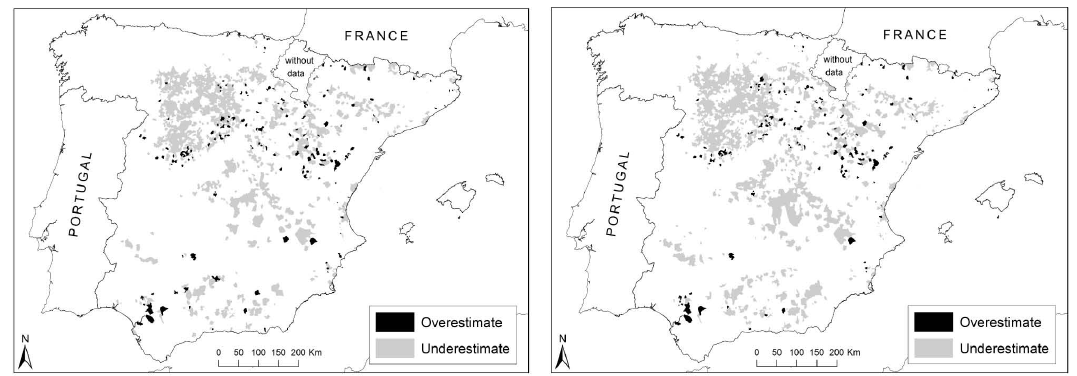
Fig. 2. Municipalities where prediction and observation data did not agree; either fire is predicted when it is not observed (overestimated) or fire is not predicted when it is observed (underestimated). Ordinary logistic regression on the right and GW logistic regression on the left. Table 2. Residual spatial performance of logistic models using the Average Nearest Neighbour Distance Analysis. Ordinary Binary logistic model GW Binary Logistic model Total Over- Under- Total Over- Under- errors estimated estimated errors estimated